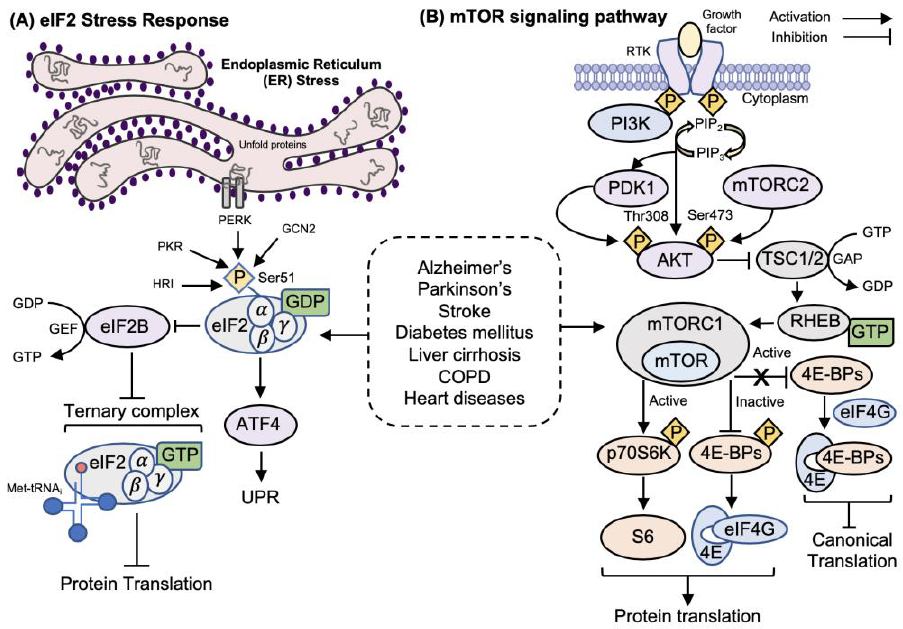
Figure 3. Human diseases linked to eIF2 Ser-51 phosphorylation stress responses and the mTORC1 signaling pathway. ( A ) Cellular stress can lead to the phosphorylation of eIF2 on Serine 51 of the α subunit (eIF2 α Ser51) by four eIF2 α kinases: heme-regulated inhibitor (HRI), protein kinase RNA- activated (PKR), PKR-like endoplasmic reticulum (ER) kinase (PERK), and general control nonderepressible 2 (GCN2); each responsive to di ff erent cellular stresses (schematic only showing ER Stress). Phosphorylation of eIF2 α inhibits translation by blocking the activity of the guanine nucleotide exchange factor eIF2B, preventing the assembly of the eIF2–GTP–Met-tRNA i ternary complex, and enhances translation of stress response mRNAs such as those encoding activating transcription factor 4 (ATF4), which can escape the inhibition of general translation by an indirect mechanism,